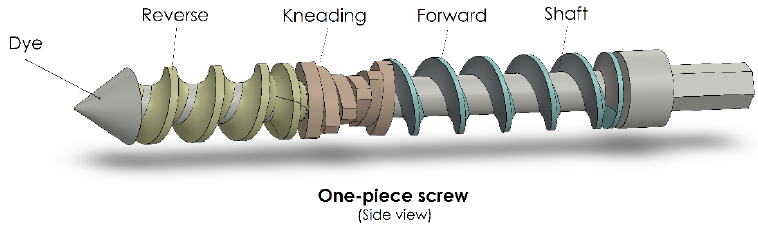
Figure 4. One-piece screw.